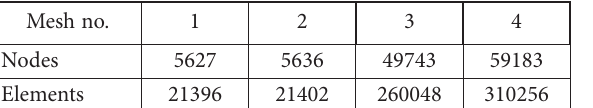
Table 3. Air and fuel flows and their ratio